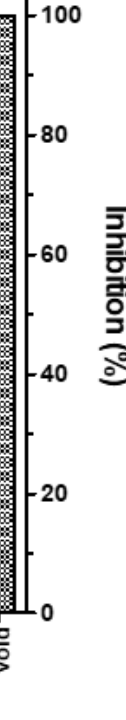
Figure 6. COX-1 inhibition assay results. Compounds were tested at a concentration of 22 μ M.